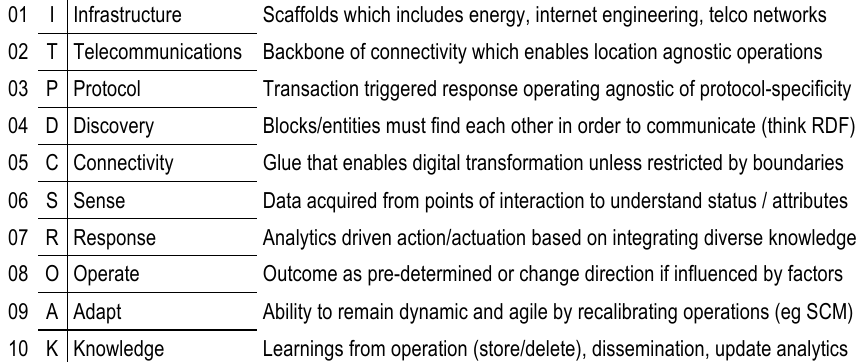
Table 1. Layers, and components for this engineering ecosystem 01 I Infrastructure Scaffolds which includes energy, internet engineering, telco networks 02 T Telecommunications Backbone of connectivity which enables location agnostic